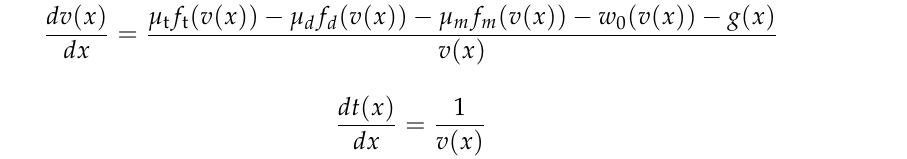
(cid:104) n ∑ g grad ( x i ) · m i i = 1